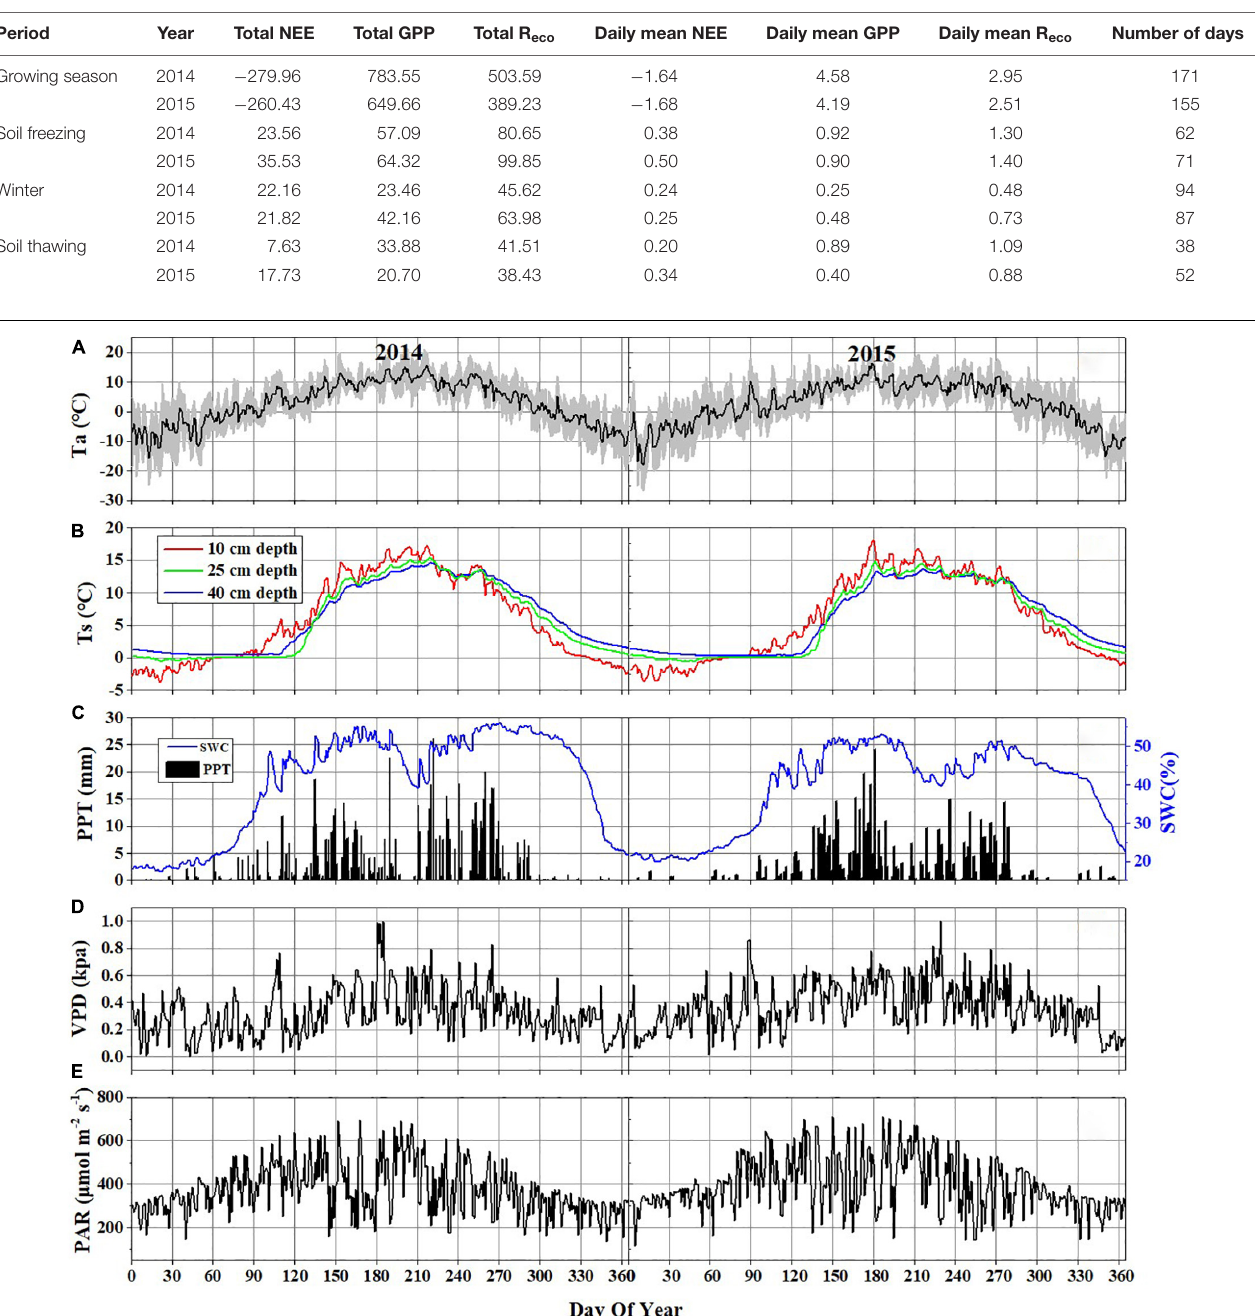
TABLE 1 | Cumulative NEE, GPP, and R eco and daily mean of NEE, GPP, and R eco (g C m − 2 ) in 2014 and 2015. Period Year Total NEE Total GPP Total R eco Daily mean NEE Daily mean GPP Daily mean R eco Number of days